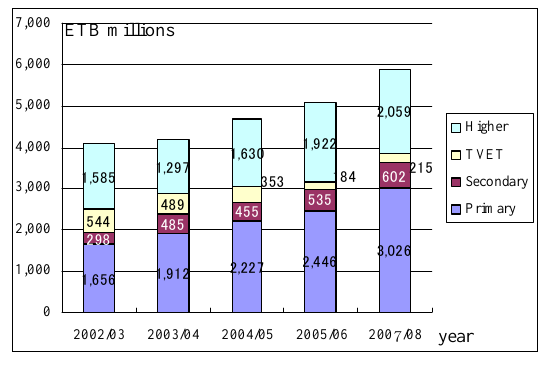
(Source: DFID, 2010) Figure 5-3: Education Subsectors as percentage of Education Expenditure (2002/03 - 2007/08)